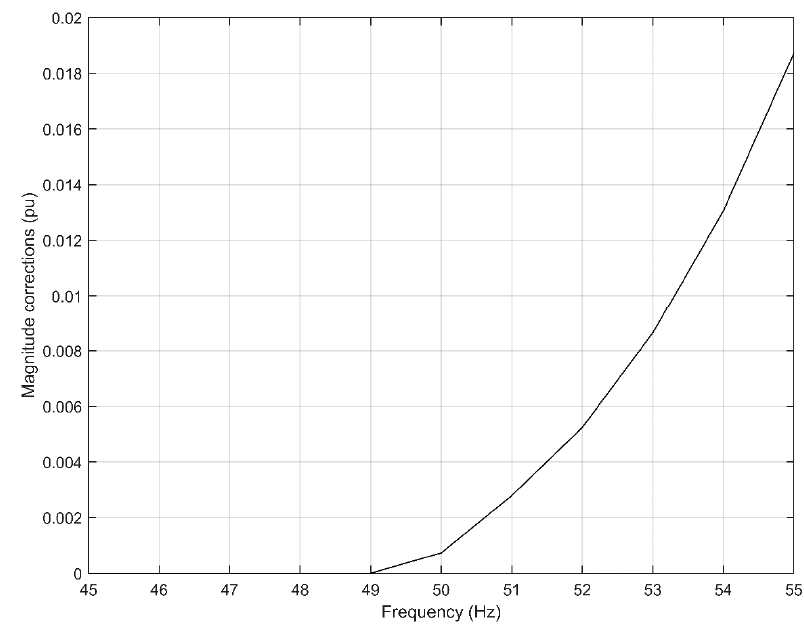
Figure 3. The magnitude estimation correction as a function of the input signal frequency.